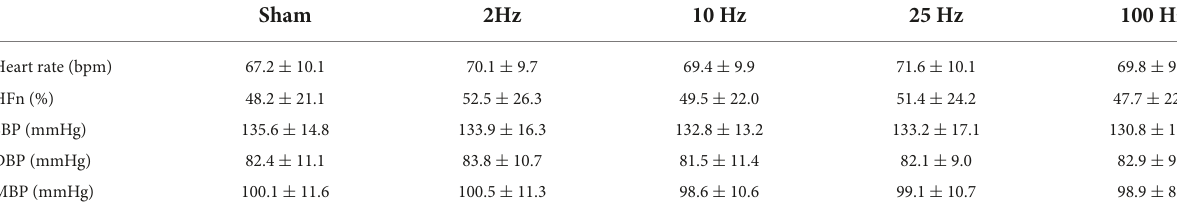
TABLE 3 Baseline hemodynamic variables across stimulation sessions.*